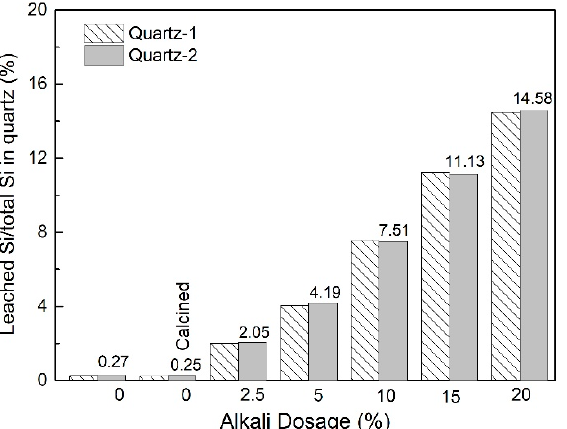
Figure 8. Leached Si content of quartz and activated quartz.